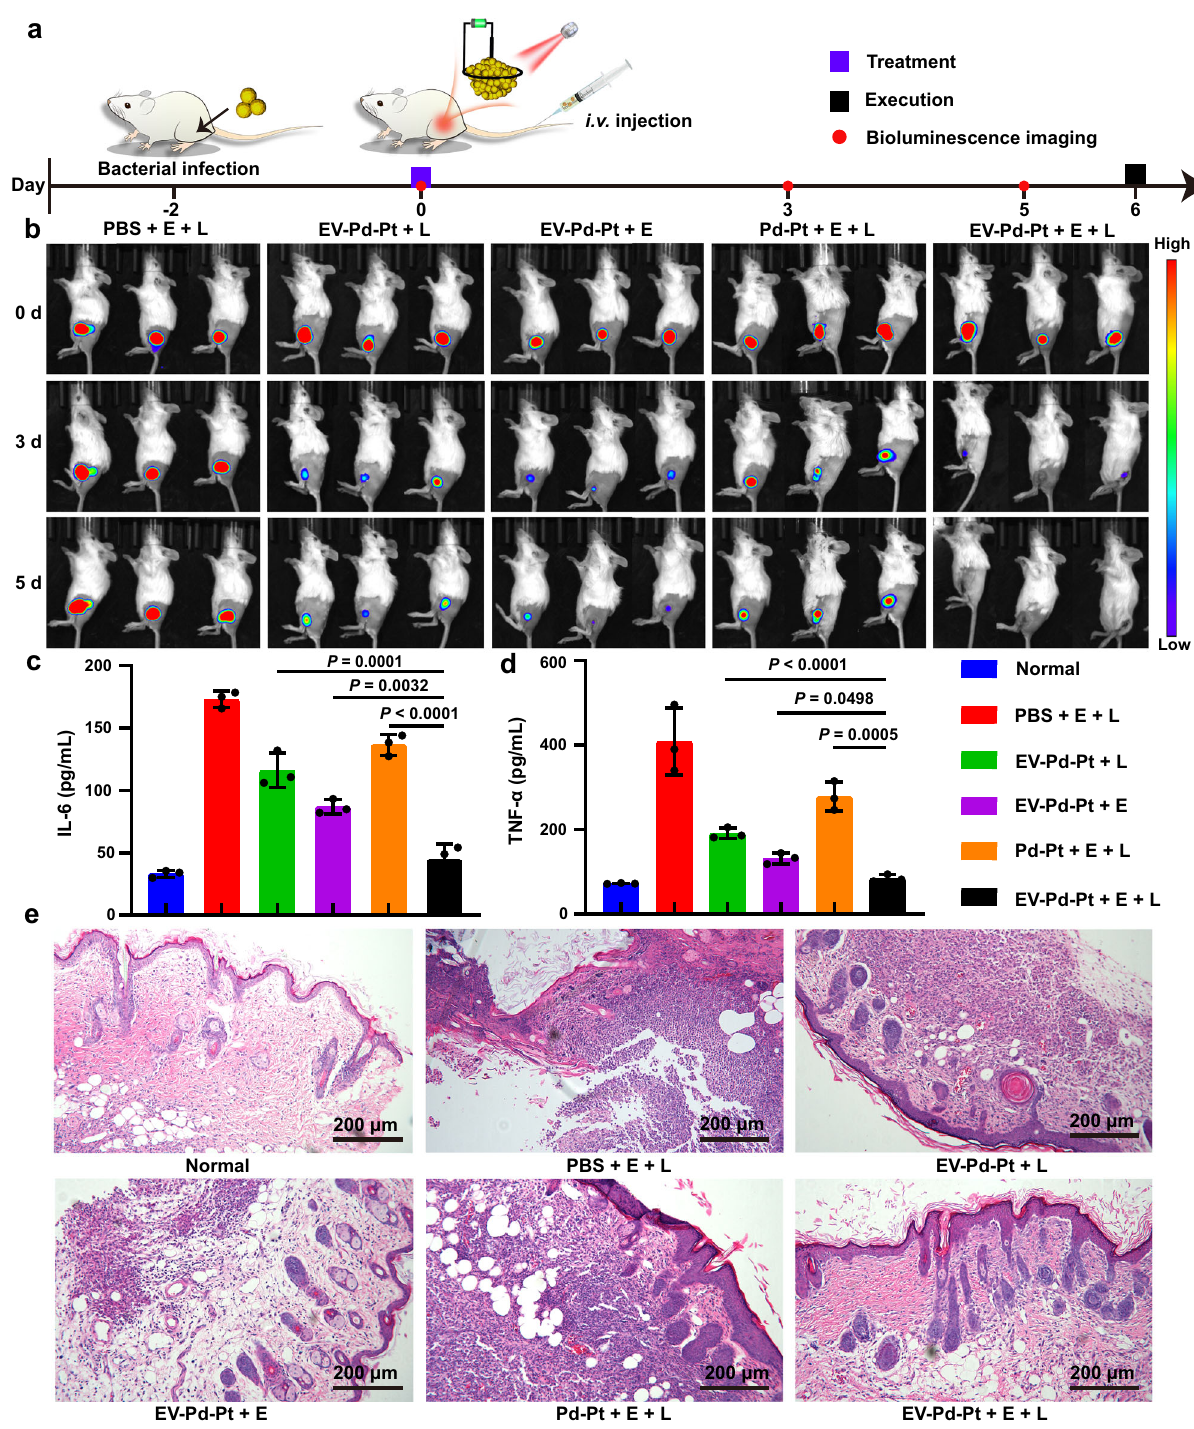
Fig. 8 | In vivo antibacterial effect of EV-Pd-Pt on the luciferase-expressing S. aureus -infectedmicemodel.a Schedule of the infection, systemic treatment,and monitoring of subcutaneous abscess in mice with bioluminescence imaging after intravenous (i.v.) injection. b Bioluminescence images of S. aureus -infected mice withdifferenttreatmentsondays0,3,and5.Quantitativeanalysisofin fl ammatory